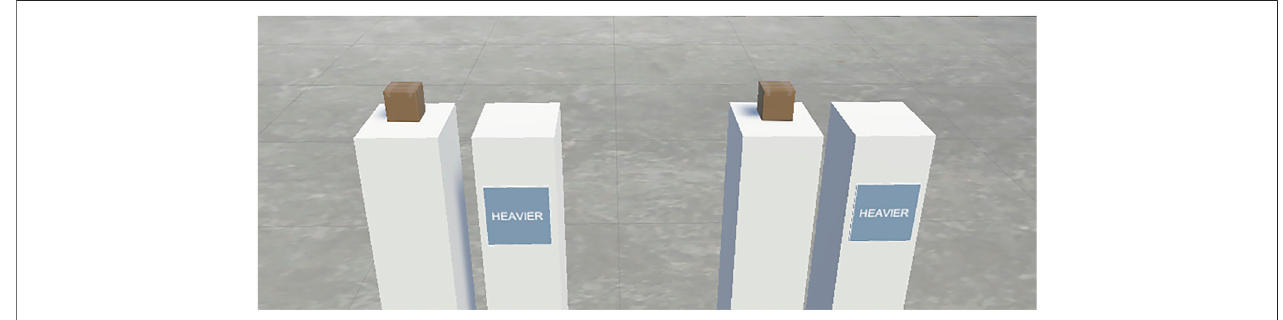
FIGURE 4 | Setup in the VE used for the main user study. Both boxes had to be lifted and placed onto the platform right next to it. Virtual “ HEAVIER ” -buttons on both target platforms allowed participants to log in their response. The same setup was used for the preliminary testing of the pilot study.